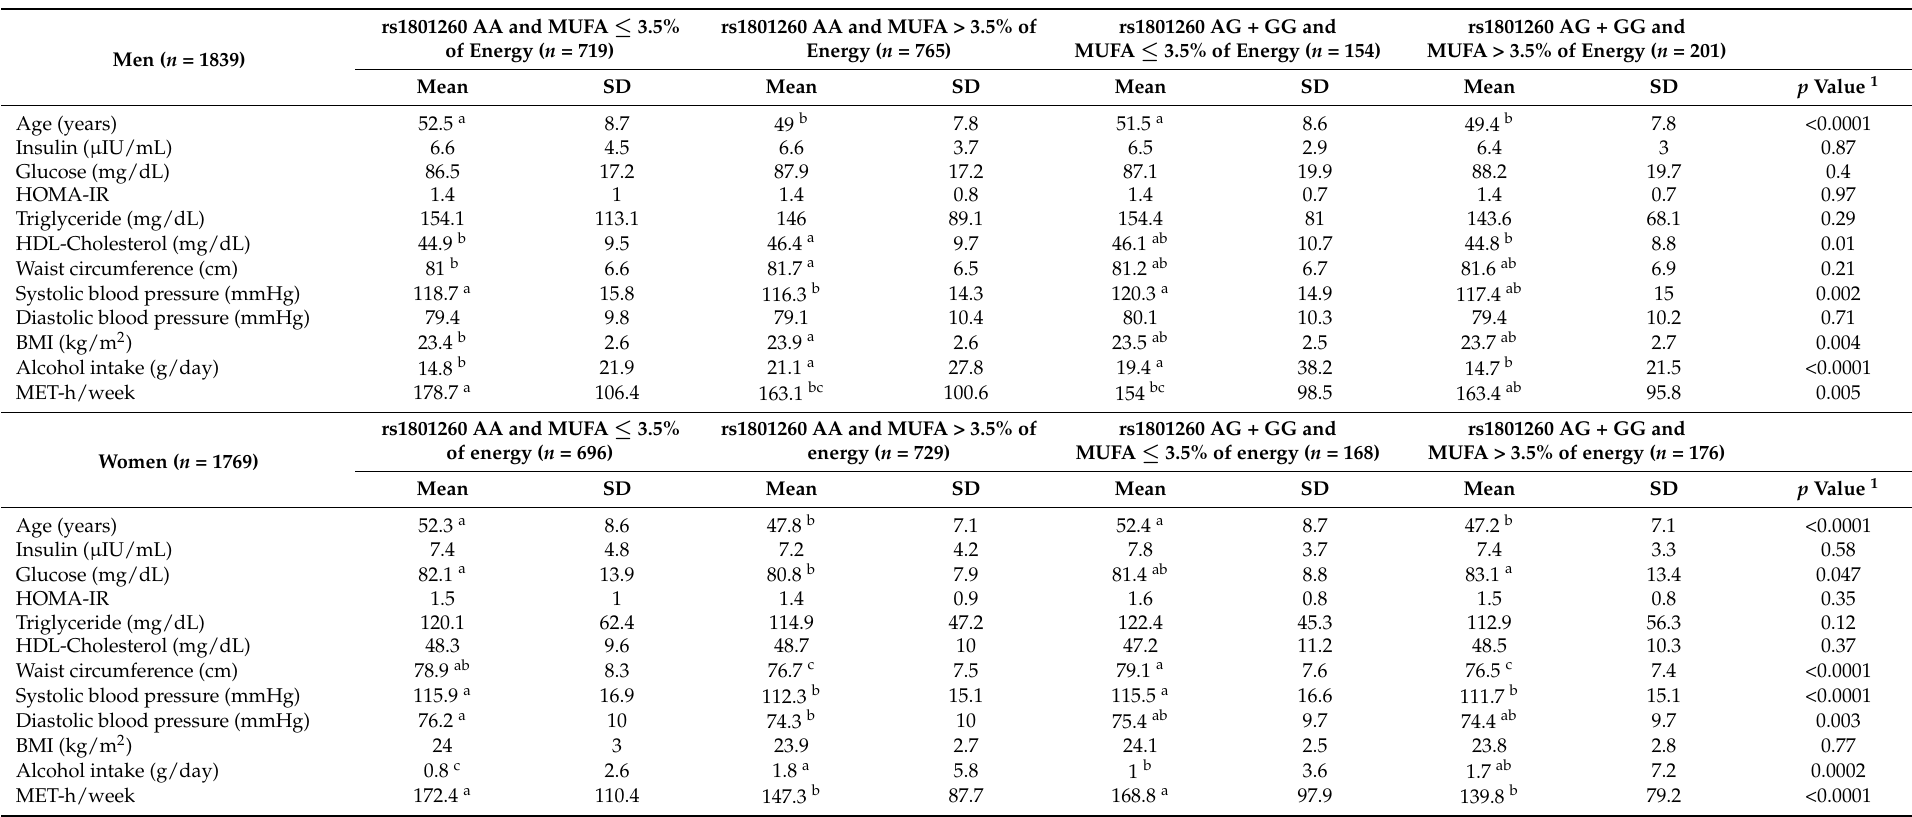
Table 3. Sociodemographic, clinical, and lifestyle characteristics of the study participants at baseline according to the CLOCK rs1801260 genotype and dietary monounsaturated fatty acid (MUFA)